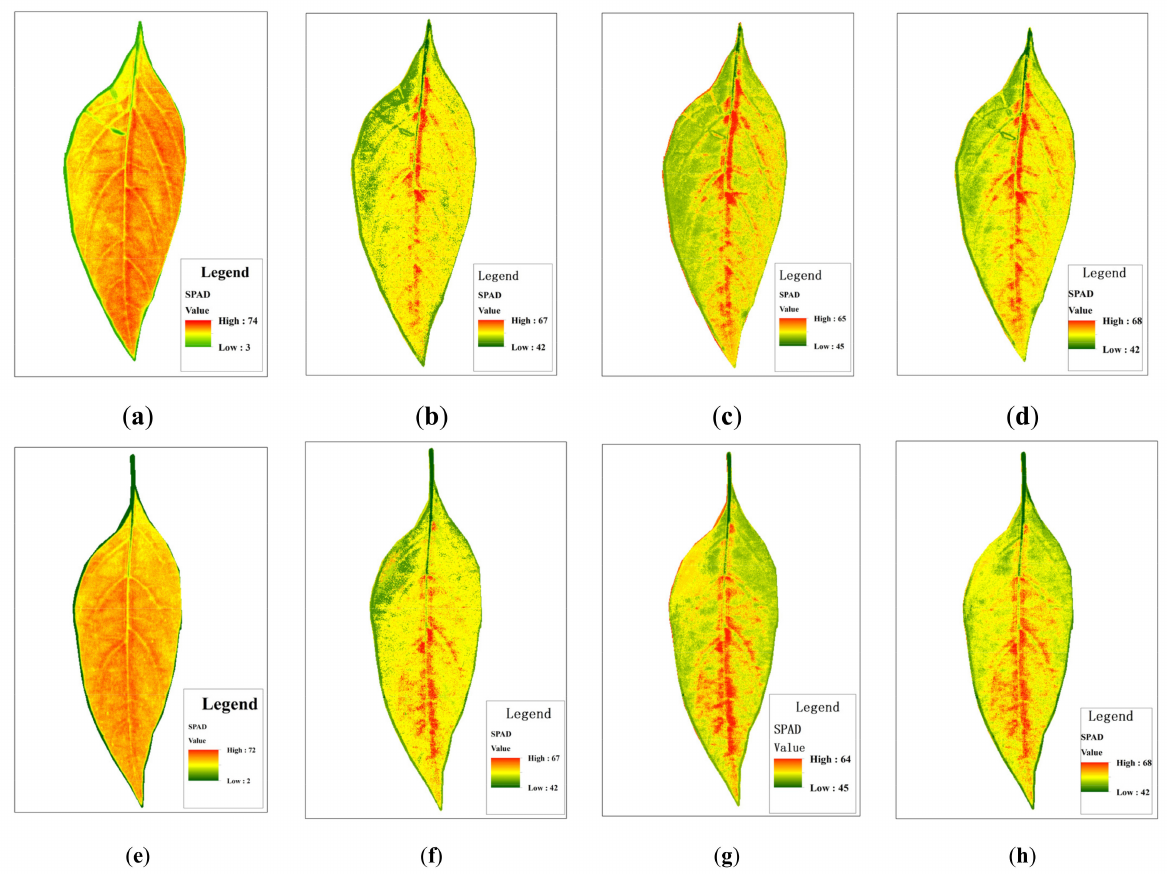
Figure 13. Distribution of SPAD value in the upper leaf in different models: ( a , e —PLSR), ( b , f —XGBoost), ( c , g —RFR), ( d , h —GBDT).